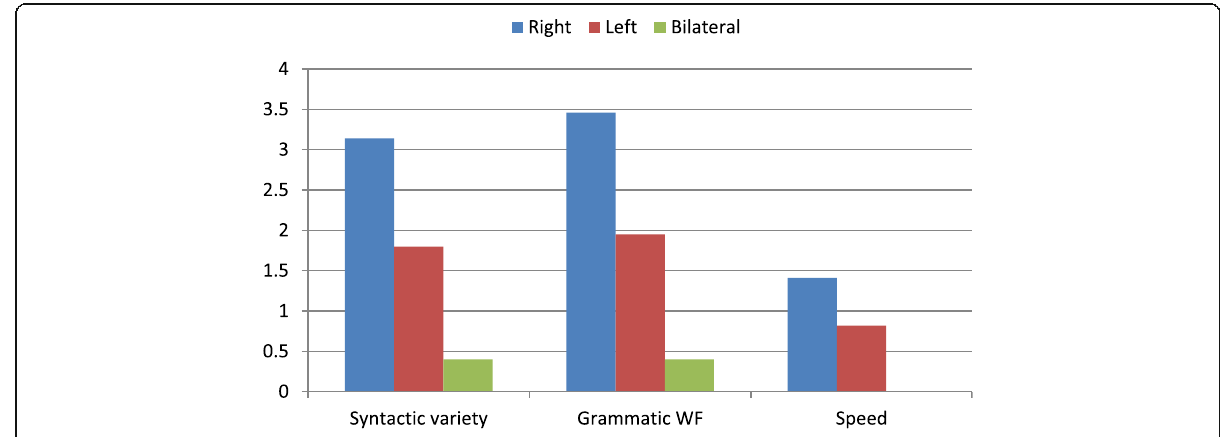
Fig. 7 Relation between syntactic variety, grammatic well formedness, speed of speech, and lesion side of stroke